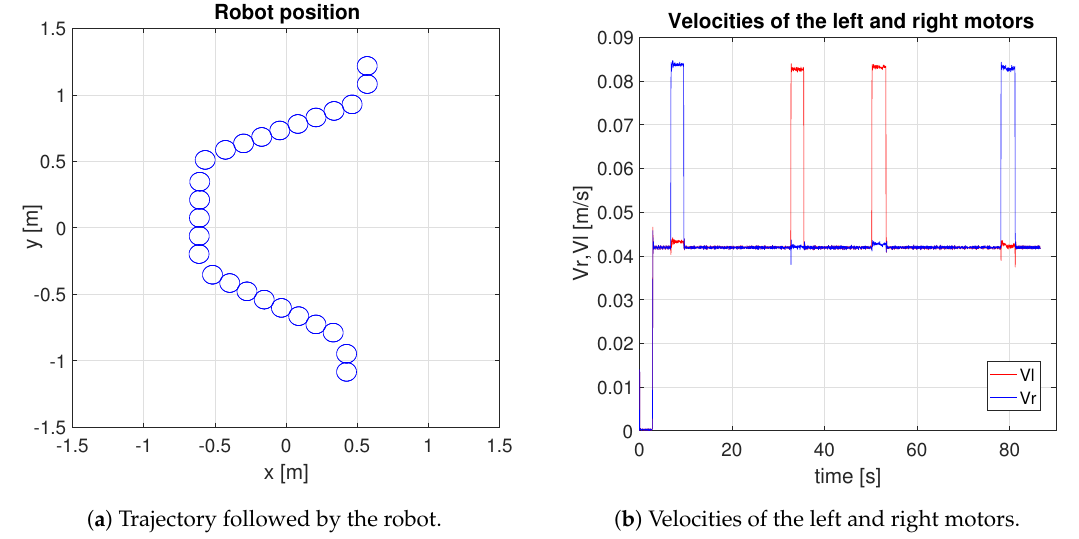
Figure 8. Experiment carried out in simulation environment.